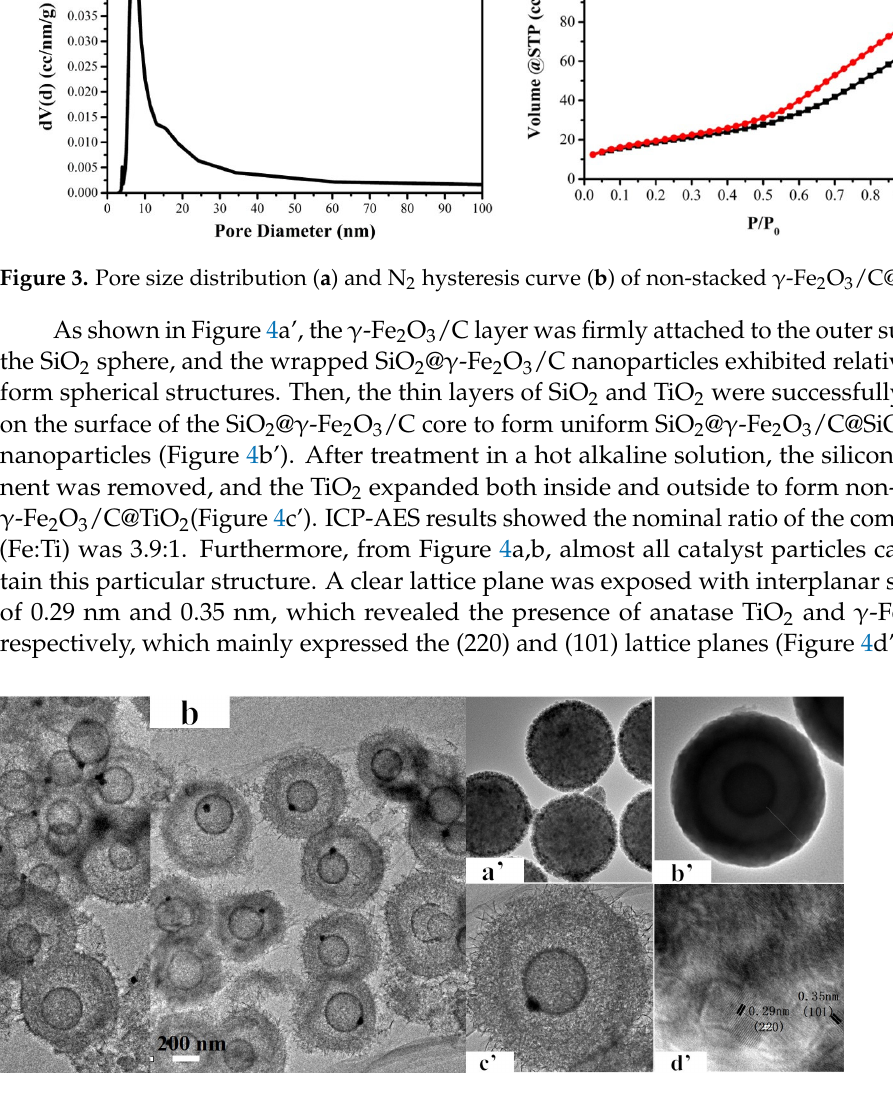
γ -Fe 2 O 3 /C@TiO 2 .